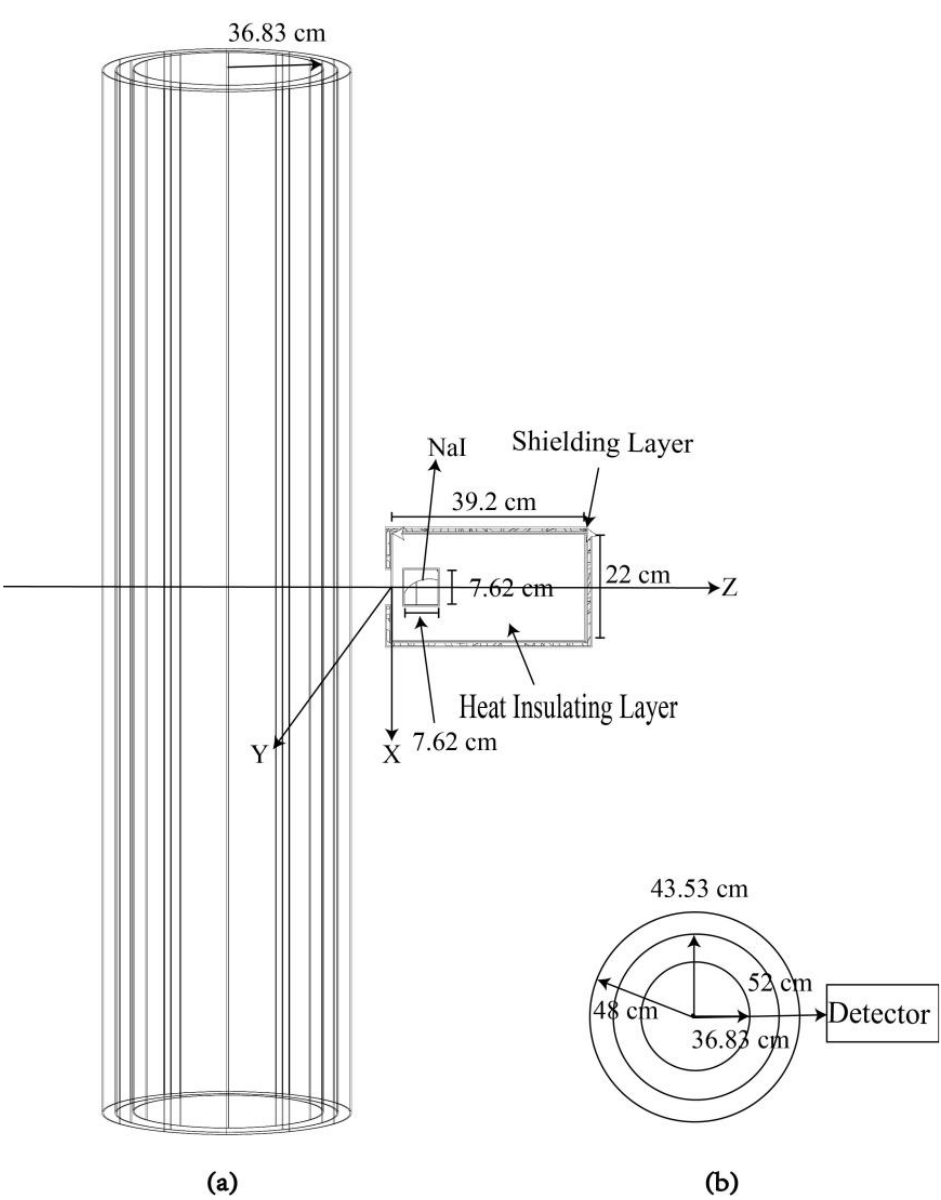
Figure 1. Position design of the detector and secondary circuit steam pipe. ( a ) Front view. ( b ) Side view.